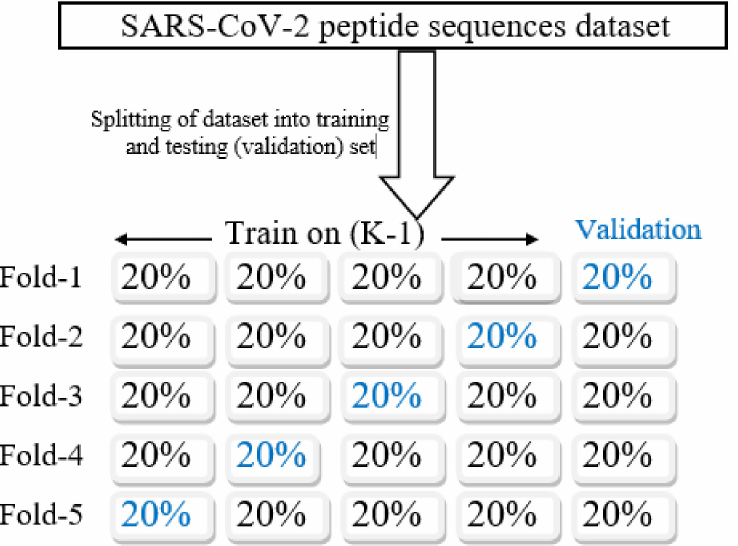
Figure 4. K-fold cross-validation process (K =